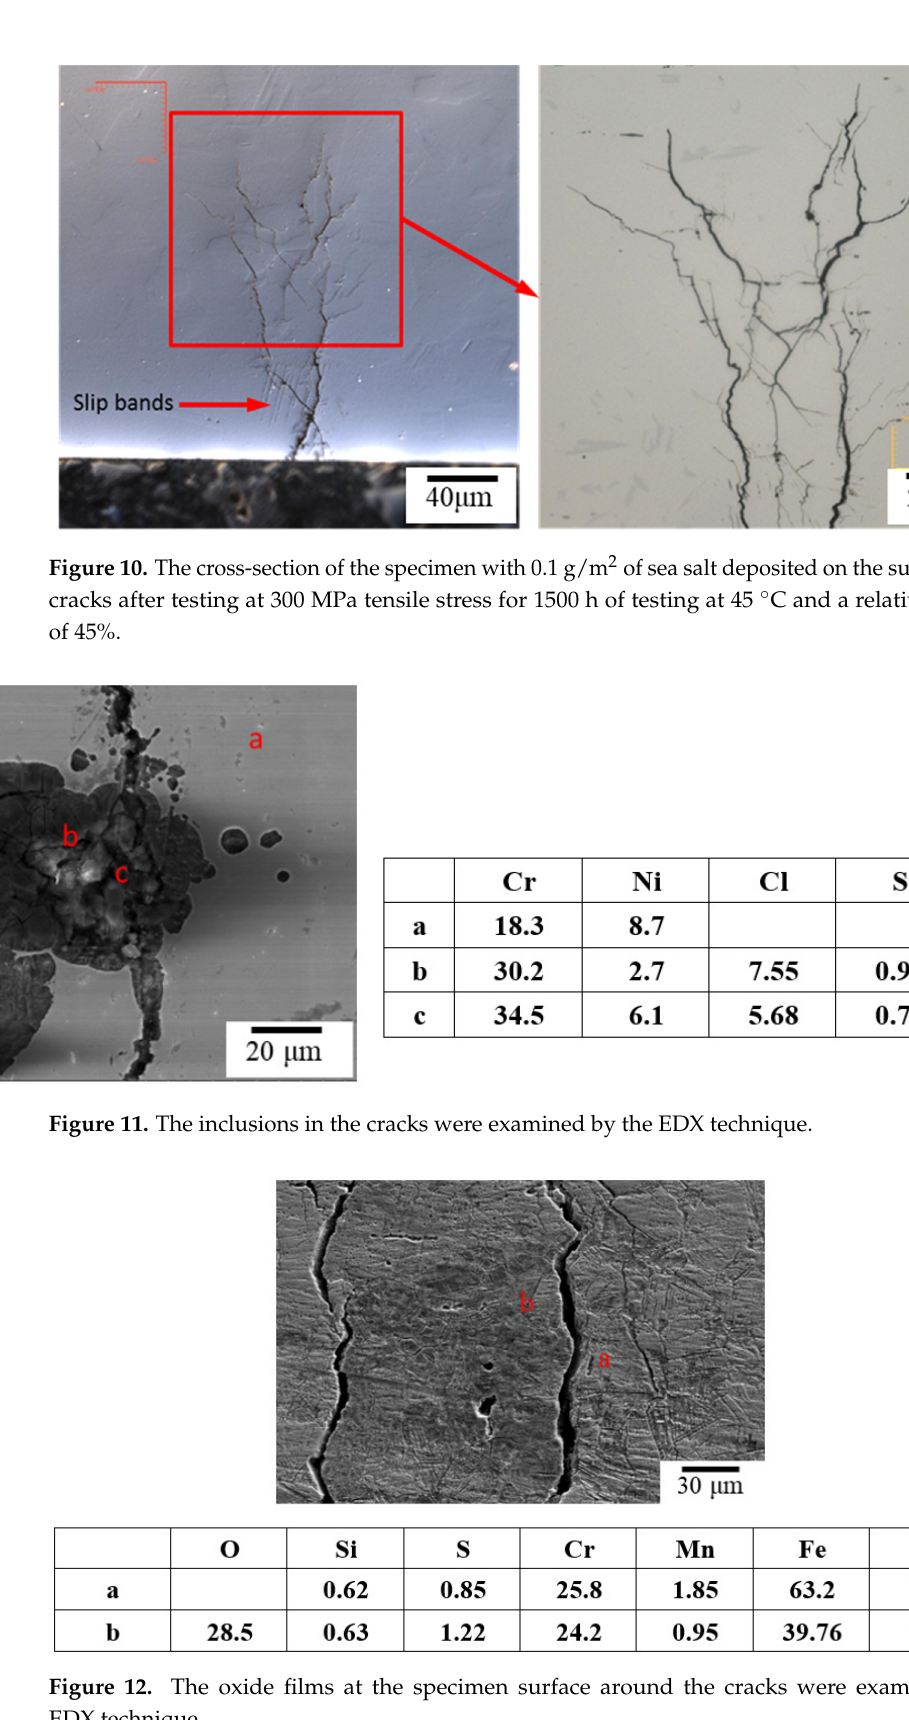
Figure 9. The crevice corrosion specimen with 0.1 g/m 2 of sea salt deposited on the surface subjected to tensile stresses of 300 MPa reveals cracks after 1500 h of testing at 45 °C and a relative humidity of 45%.